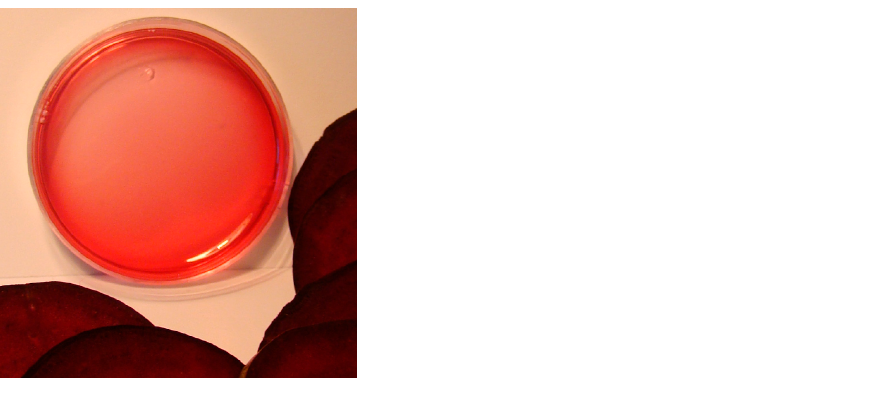
Figure 3. An example of beetroot–gelatin free-standing film containing silver nanoparticles.